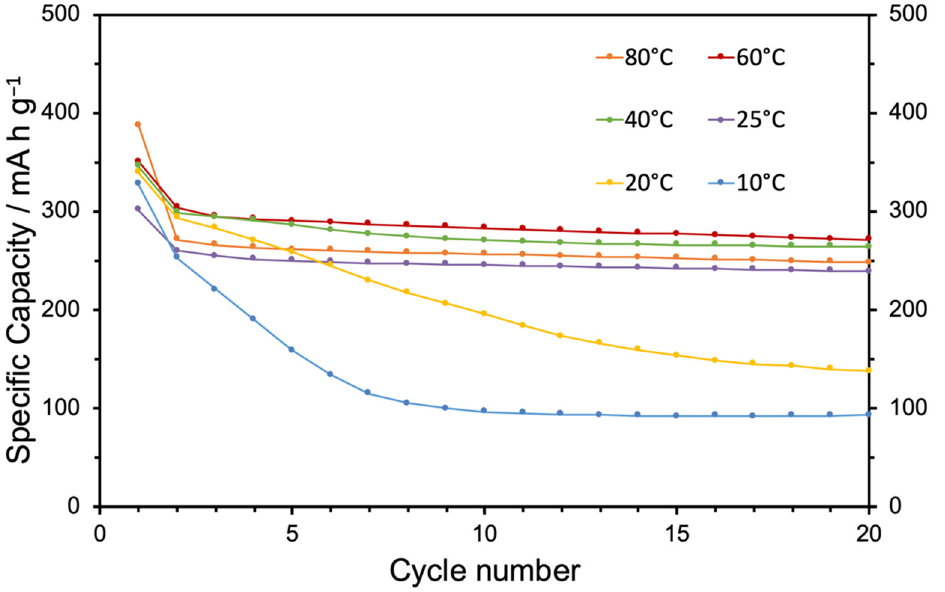
Figure 4. Oxidation specific capacity of HC at temperatures from 10 to 80 °C measured between 2 and 0.001 V (vs . Na + /Na) at 100 mA g − 1 in sodium